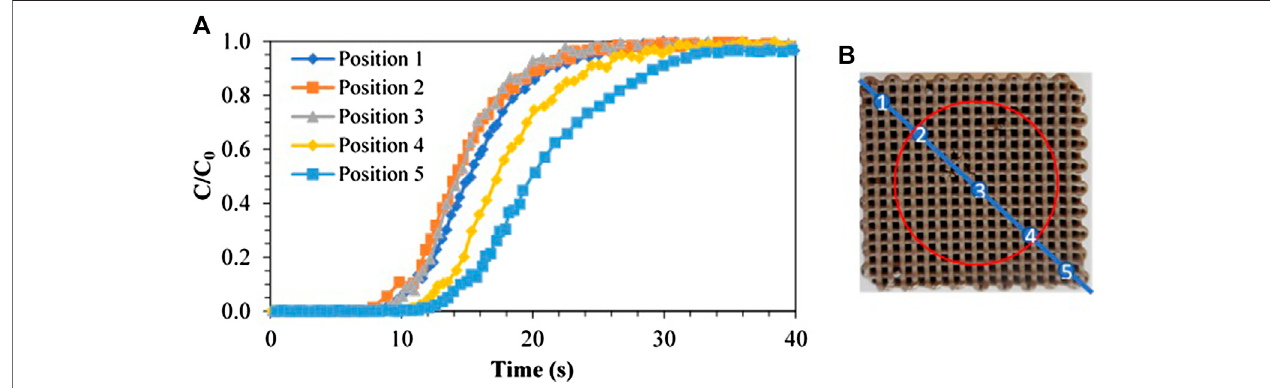
FIGURE2| Breakthroughcurvesobtainedindifferentradialpositions. (A) Breakthroughcurveinthe fi vedifferentradialpositionsalongthediagonal. (B) Schemeof the diagonal and the positions at which the breakthrough pro fi le was measured. The red circle shows the size of the inlet.